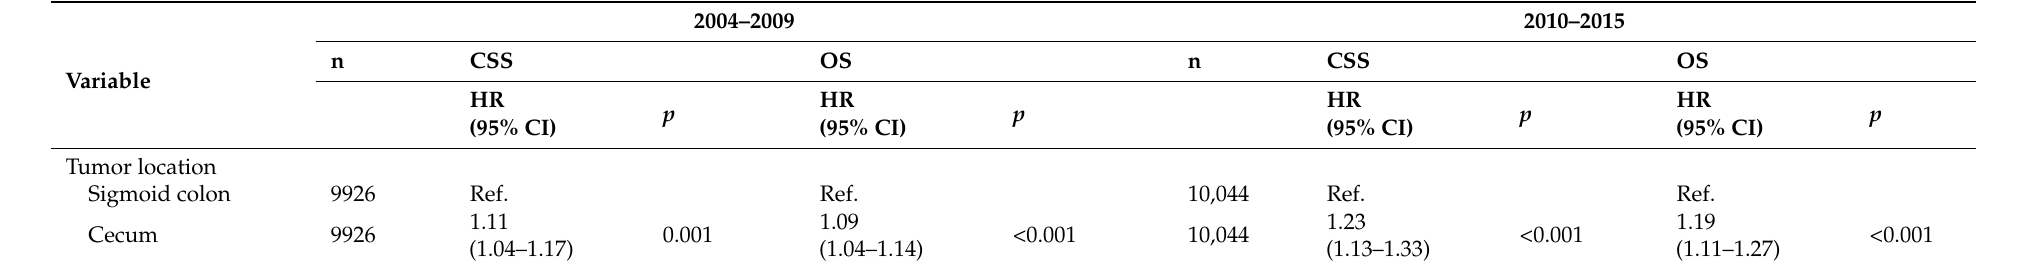
Table 5. Multivariate Cox regression analysis of prognostic factors after propensity score matching. Variables with p value less than 0.01 in univariate analysis were incorporated into multivariate Cox regression